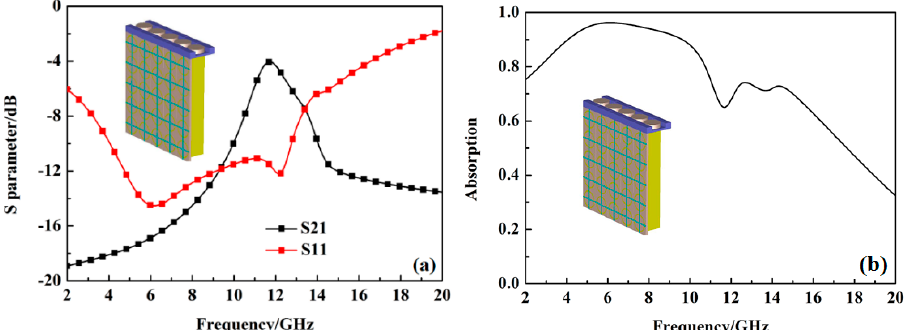
Figure 3. The S parameters and absorption when the rotatable metal plate is perpendicular to the rest of the layers, ( a ) the S parameters; ( b ) the absorption.